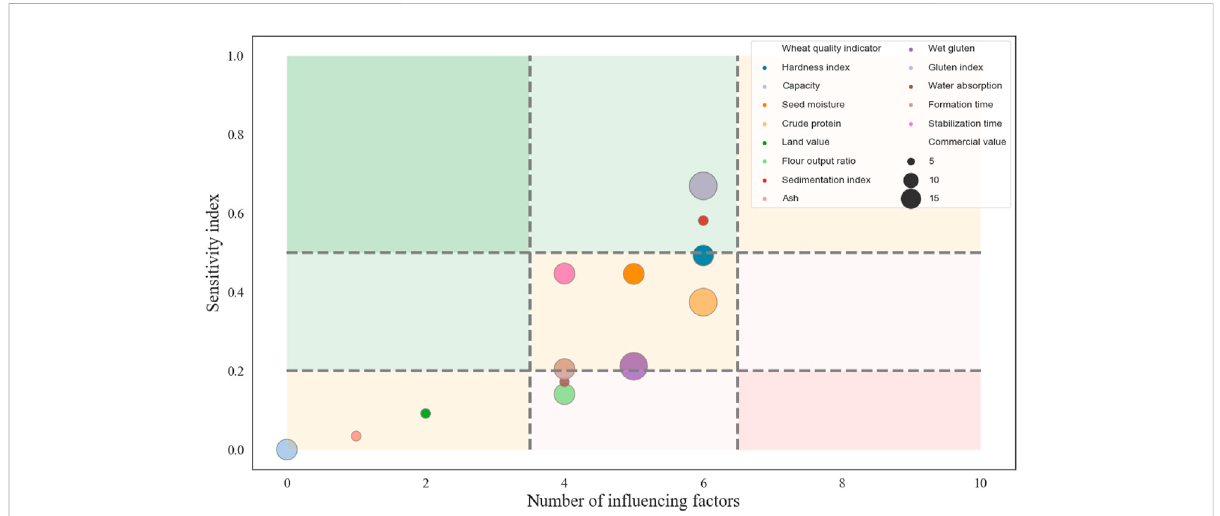
FIGURE 6 PrioritystrategiesforwheatqualityimprovementintheG×E×Mframework.Thedotsinthe fi gurerepresentwheatqualitytraits.Thesizeofthe dotsimpliestheimportanceofwheatqualitytraitsinagriculturalpractices.Thepriorityofwheatqualityimprovementisdemonstratedbytheposition ofwheatqualitytraits,withtraitsneartheupperrightcornerimplyingahigherpriority.Greendenoteshighpriority,lightgreendenotesrelativelyhigh priority, orange denotes medium priority, light pink denotes relatively low priority, and dark pink denotes a low